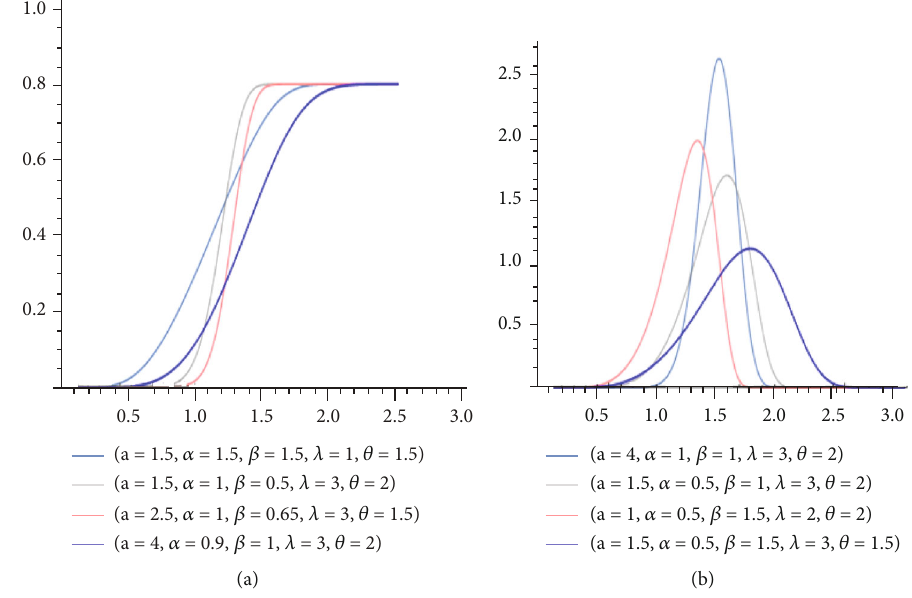
Figure 1: Plots of (a) CDF and (b) PDF with numerous values of a , α , β , λ , and θ